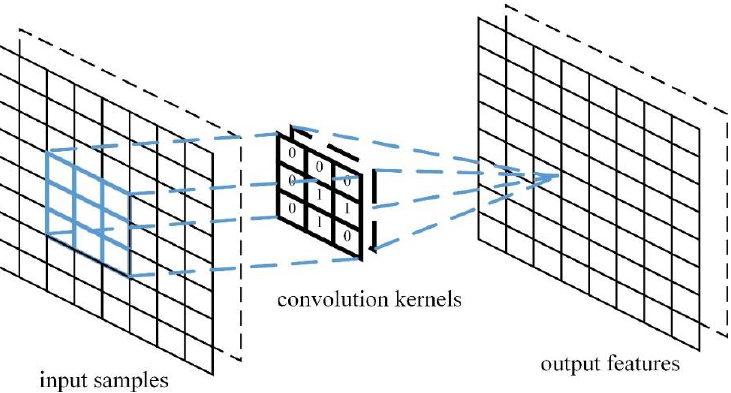
Figure 3. The operation of the convolution layer.